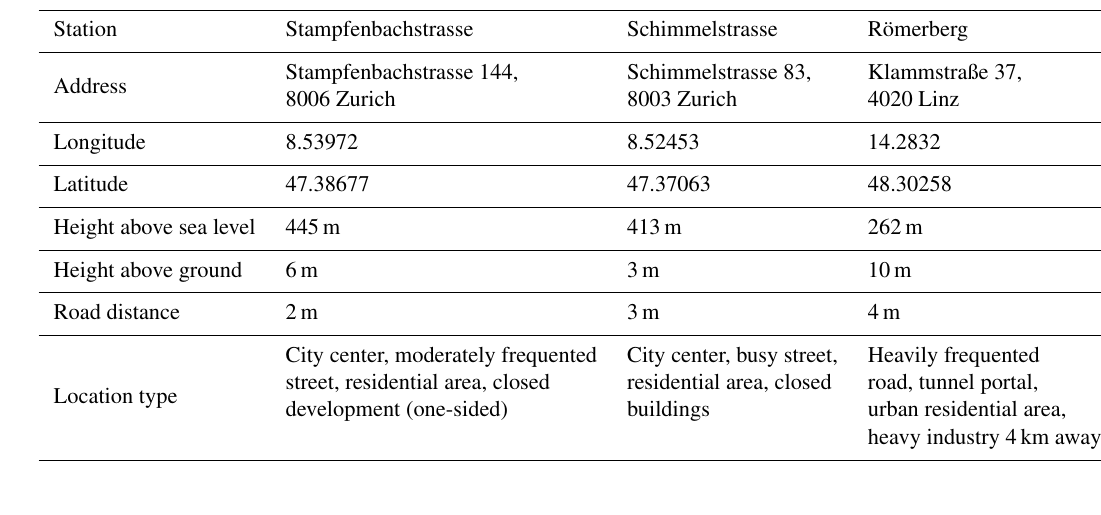
Table 4. Correlation coefficient ( r s ) of the reference station Stampfenbachstrasse and the sensor 574.